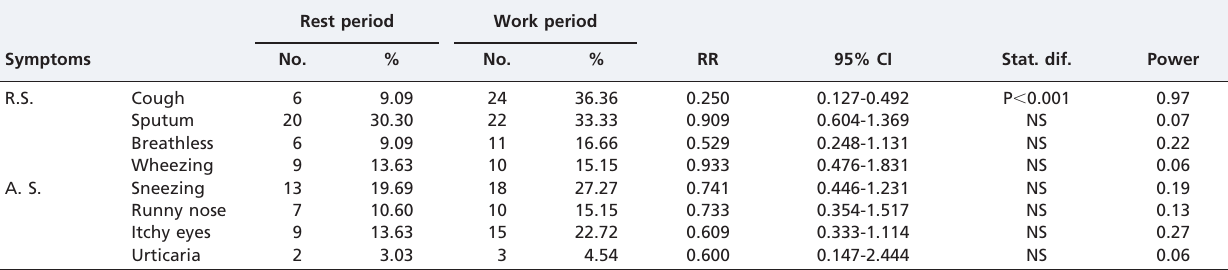
Table 3 - Comparison of respiratory symptoms in carpenters between rest and work periods. Rest period Work period